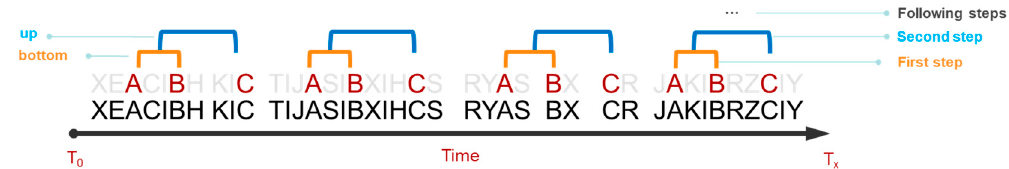
Figure 1. Hypothetical T-pattern consisting of three events during an observational period (T0–Tx) encompassing a total of 40 events (bold letters near the time axis). The ((A B) C) T-pattern becomes evident if all the remaining behavioral events are left out (grey letters). “First”, “second” and “following steps” indicate search runs carried out by Theme software following a bottom-up detection process.